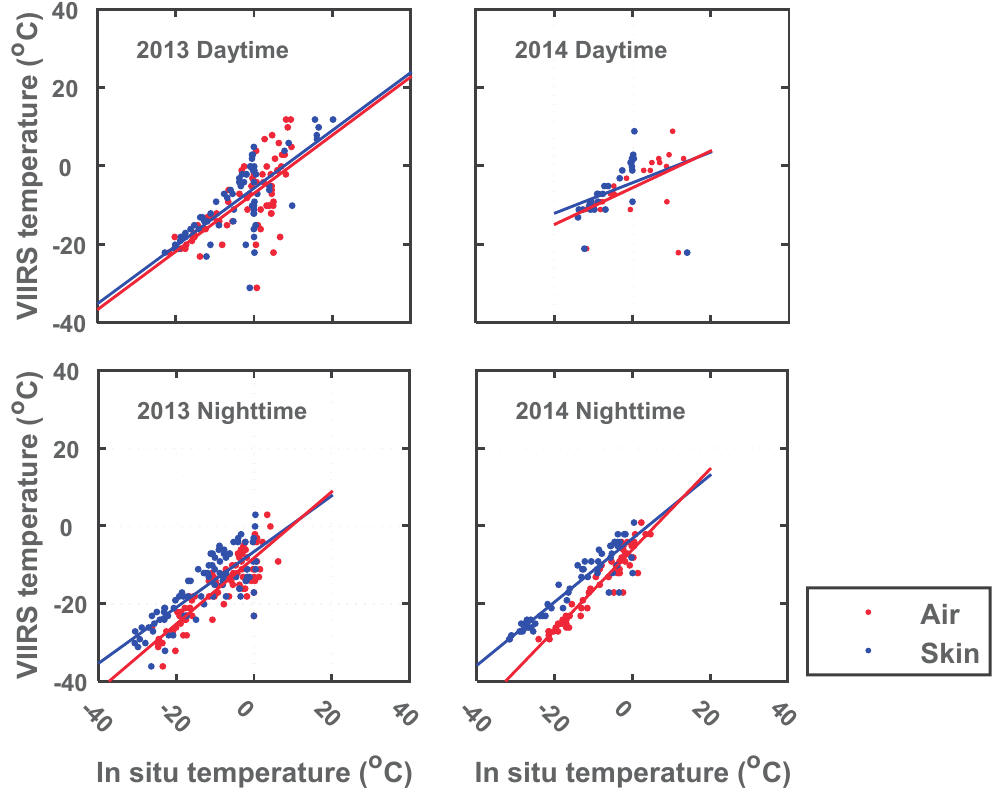
Figure 4 . CREST-SAFE in situ T-skin and T-air correlation with satellite VIIRS LST daytime and nighttime data for winters 2013 and